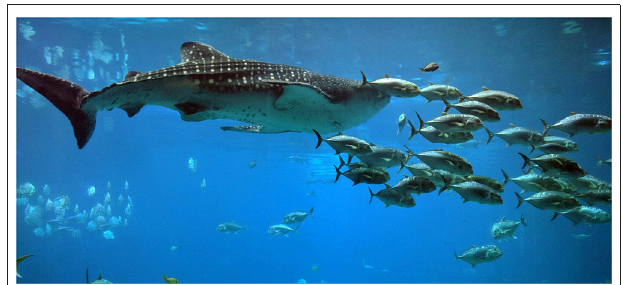
FIGURE 3 | Whaleshark and shoal of golden trevally in Georgia Aquarium, USA.